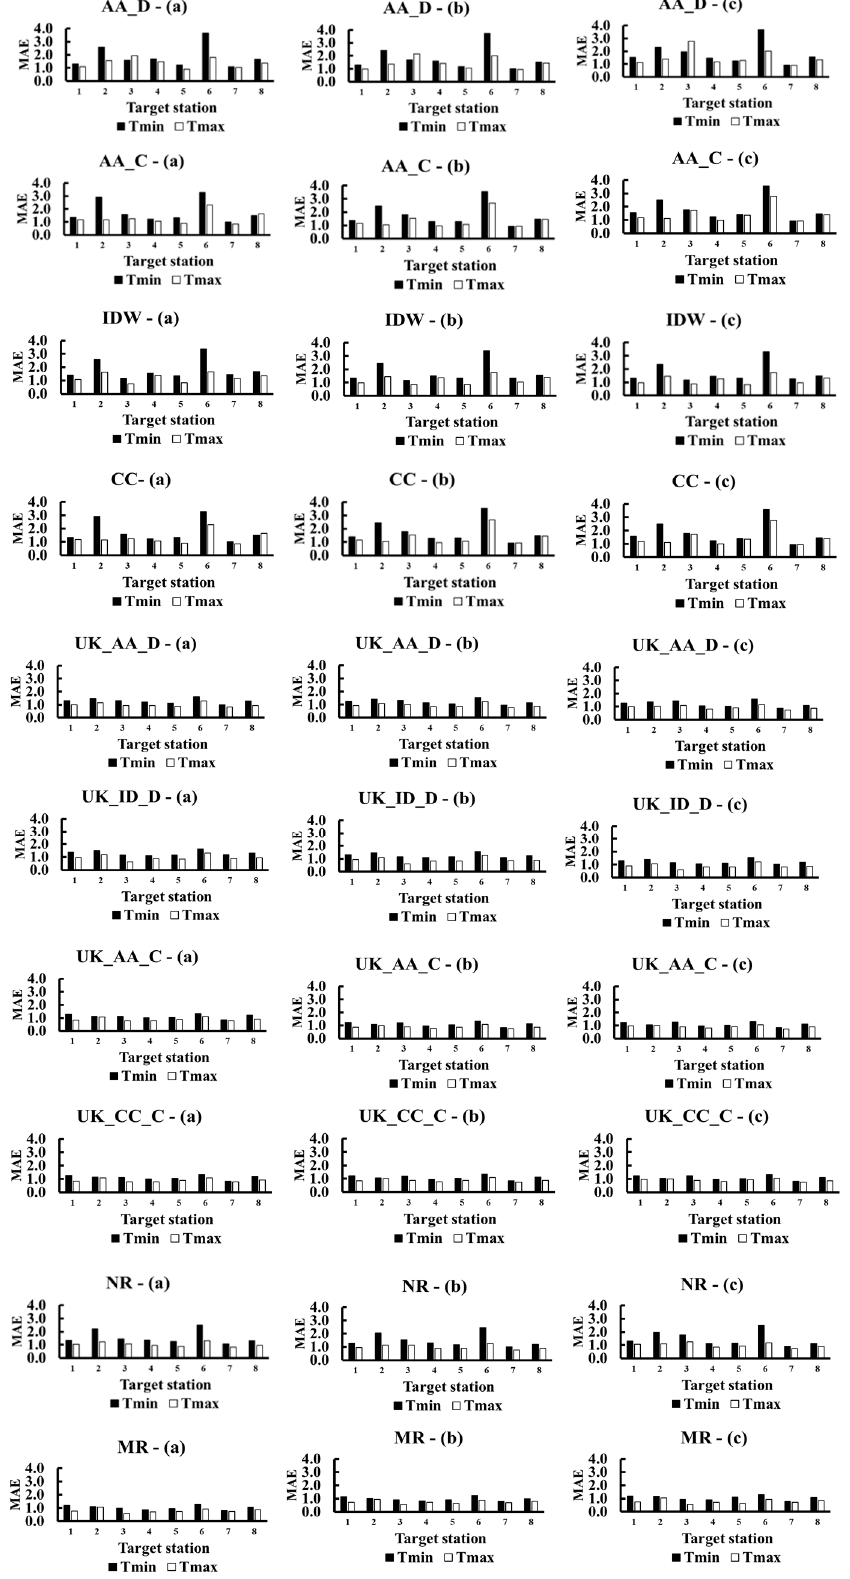
Figure 3. Mean absolute error (MAE) for estimating minimum and maximum temperatures for each infilling method at all target stations using ( a ) three target stations, ( b ) 5 target stations and ( c ) 8 target stations.